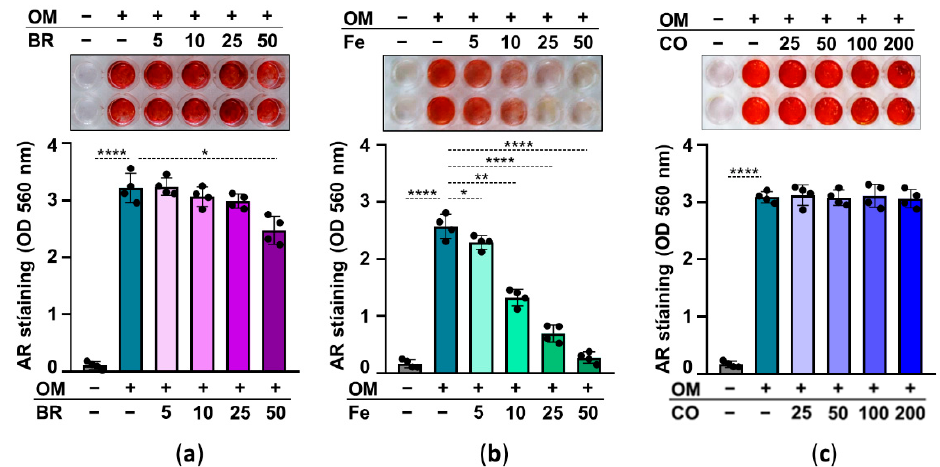
Figure 7. Effect of heme degradation products on OM-induced HuLECs calcification. ( a – c ) Conflu- ent HuLECs (passage 5–8) were treated with OM in the presence of bilirubin (BR; 5–50 µ mol/L), iron (FeSO 4 ; 5–50 µ mol/L), or CO (CORM; 25–200 µ mol/L). Calcification was assessed by AR staining (day5). Representative images from four independent experiments and quantification are shown. Data are expressed as mean ± SD. Ordinary one-way ANOVA followed by Tukey’s multiple comparison test was used to obtain p values. * p < 0.05, ** p < 0.01, **** p < 0.001.